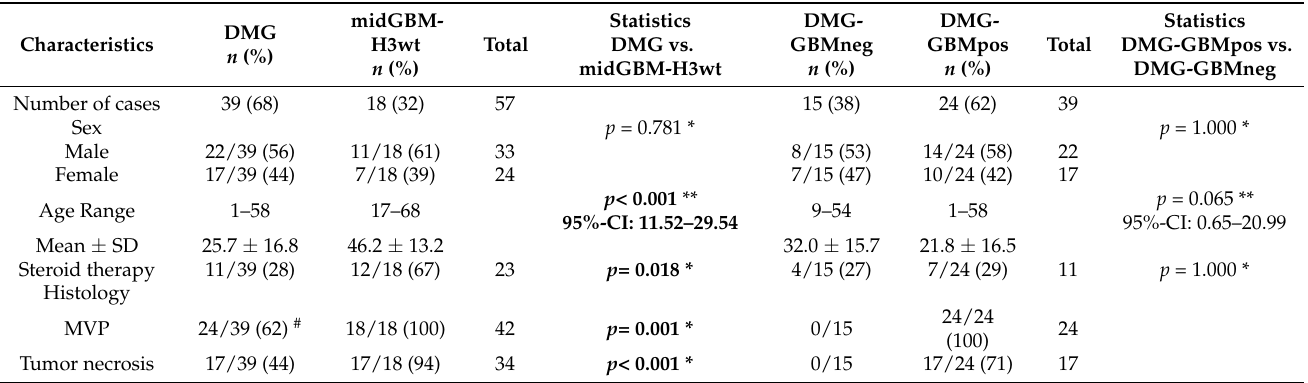
Table 1. Patient characteristics. Patients’ characteristics, steroid therapy at the time of or up to 14 days before imaging and histologic features in relation to tumor